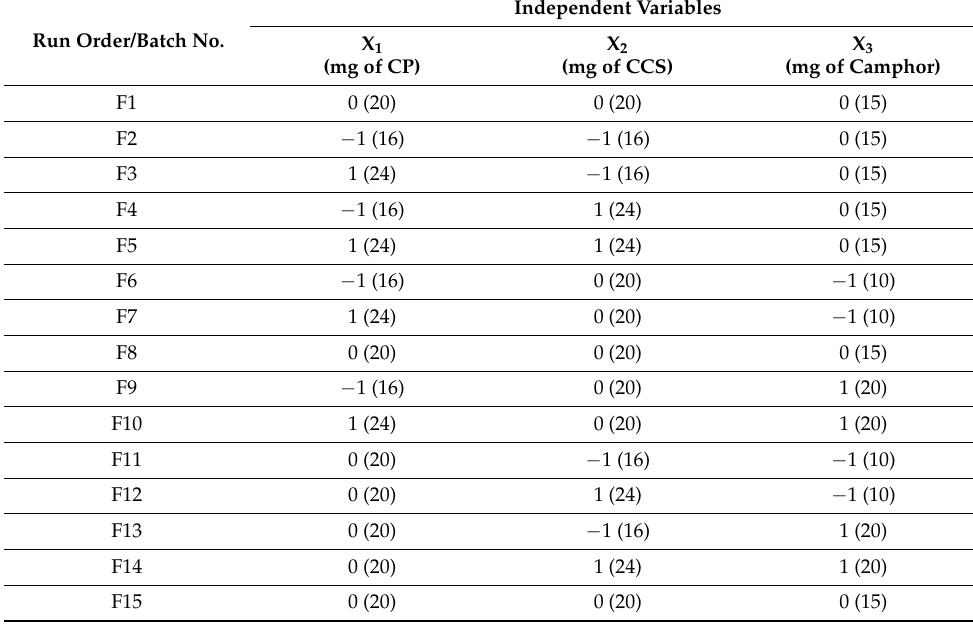
Table 2. Box-Behnken Experimental